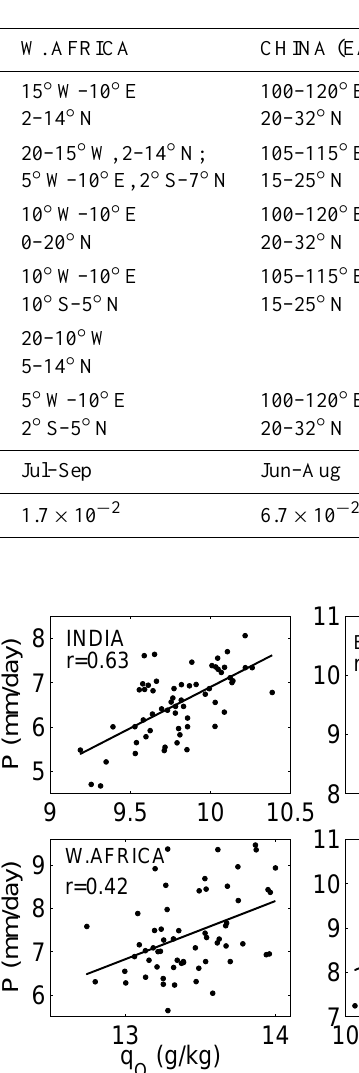
Table 1. Regional definitions used for data analysis. Monthly-mean NCEP/NCAR reanalysis data has been averaged over the indicated re- gions and seasons; land and ocean indicate that only terrestrial or oceanic grid points have been considered, respectively; and 1T = T L − T o . The bottom row lists the values for the dimensionless parameter (cid:15) that have been used in the estimation of the critical threshold (see Sect. 4).